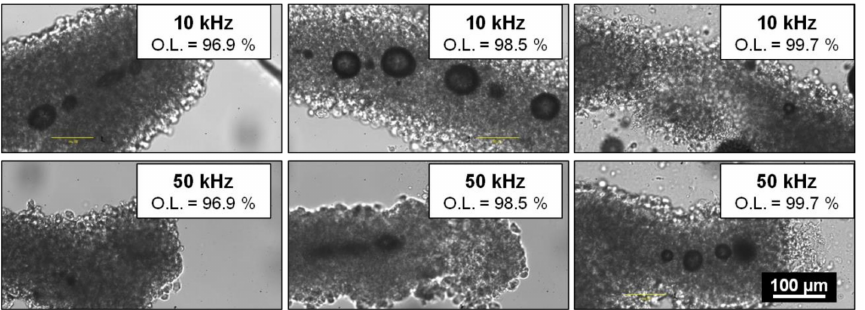
Figure 4. Cavitation bubble behavior 5s after laser processing within different microfibres with respect to the repetition rate: 10 kHz (top) and 50 kHz (bottom) and the overlap: 96.9% (left), 98.5% (middle), and 99.7% (right). Fixed parameters: λ = 1030 nm; D = 100 µ m; F = 24.5 J · cm − 2 ; 1 laser